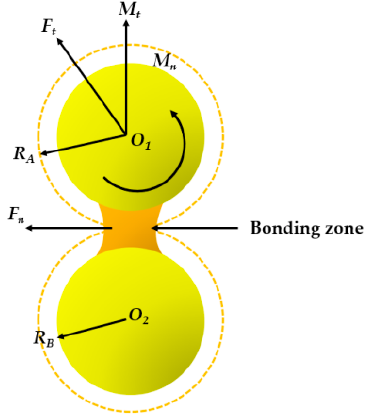
5 of 16 Figure 6. Vertical rotary cutter set model.